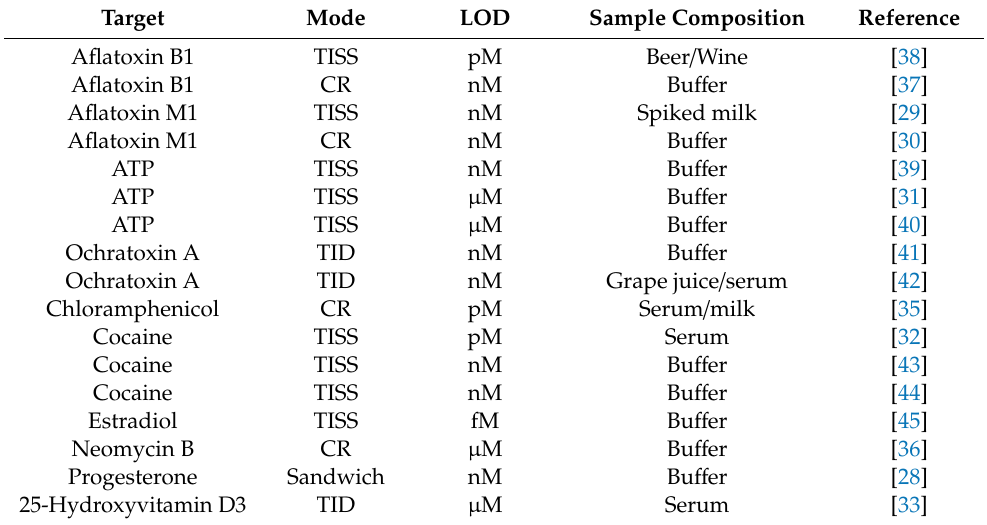
Table 1. Selection of aptasensors against a variety of small molecules with their operational modes, limits of detection (LOD) and sample